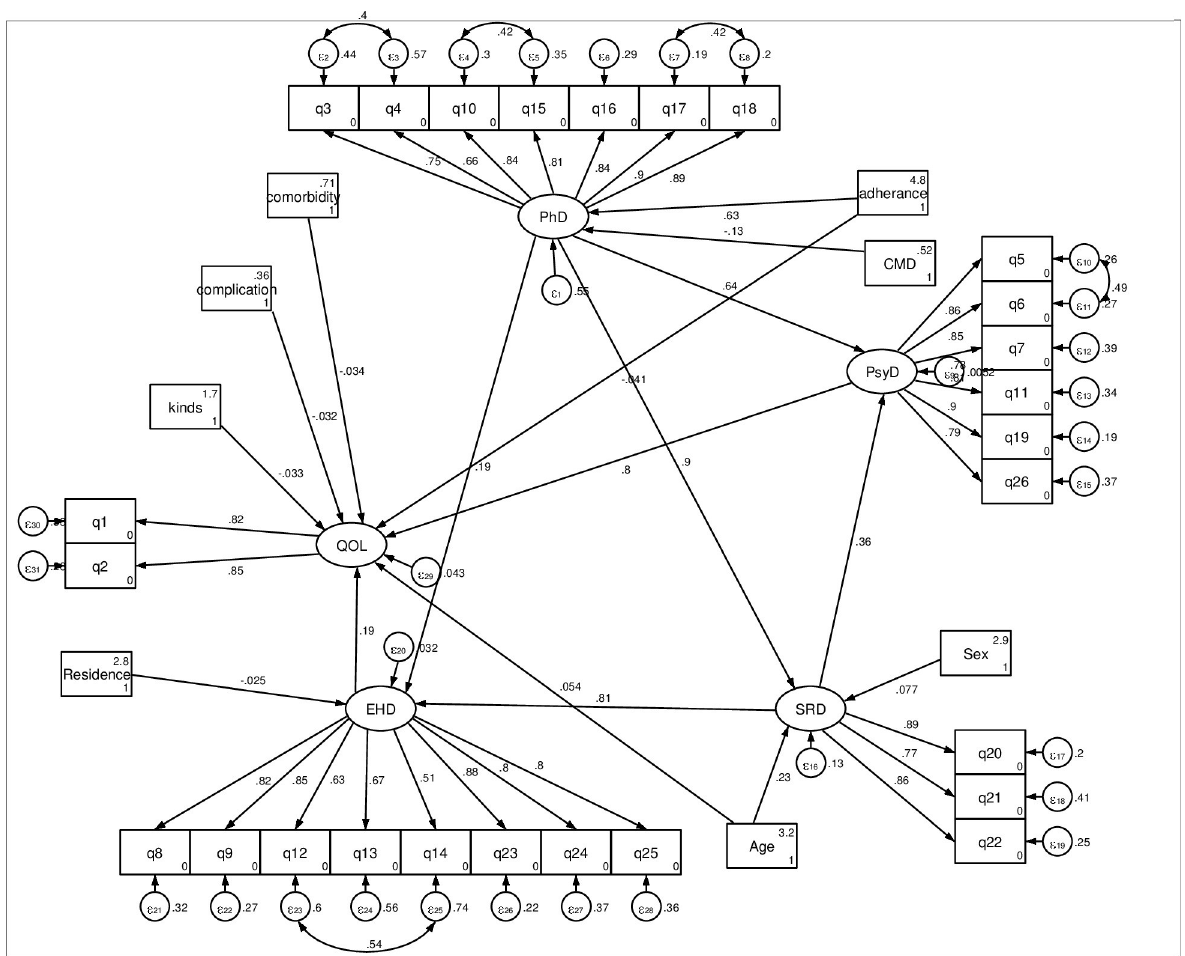
Fig 4. Causal factors for quality of life among common chronic disease patients in Amhara region, Ethiopia, derived from the SEM, 2021.